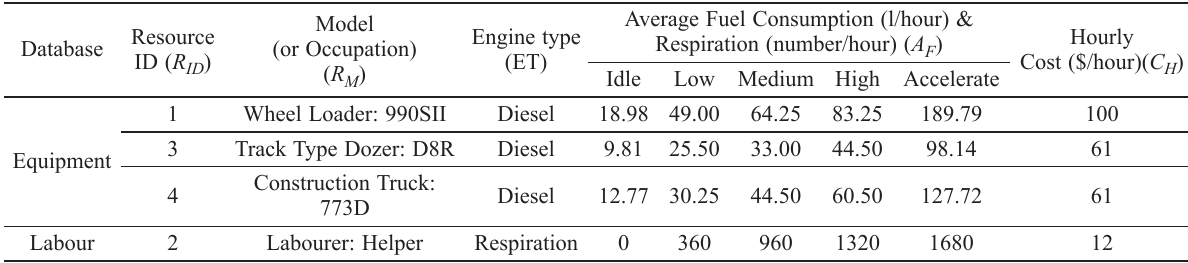
Table 2. Resources